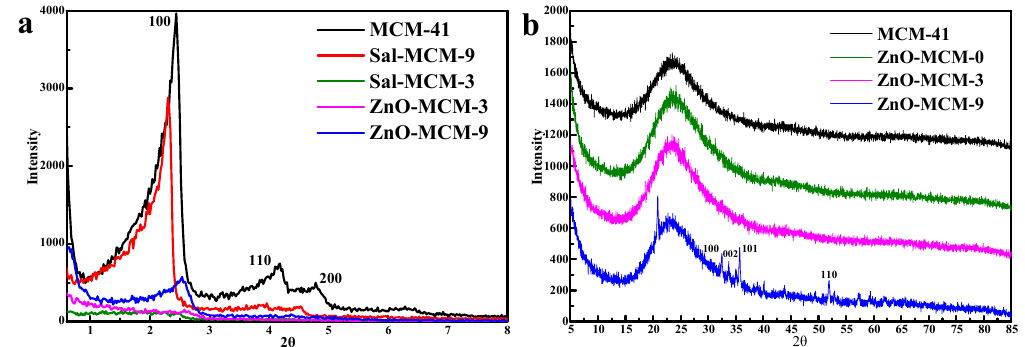
Figure 3. Low-X-ray diffraction patterns (XRD) ( a ) and Wide-XRD ( b ) patterns of MCM-41, Sal-MCM, and ZnO-MCM.